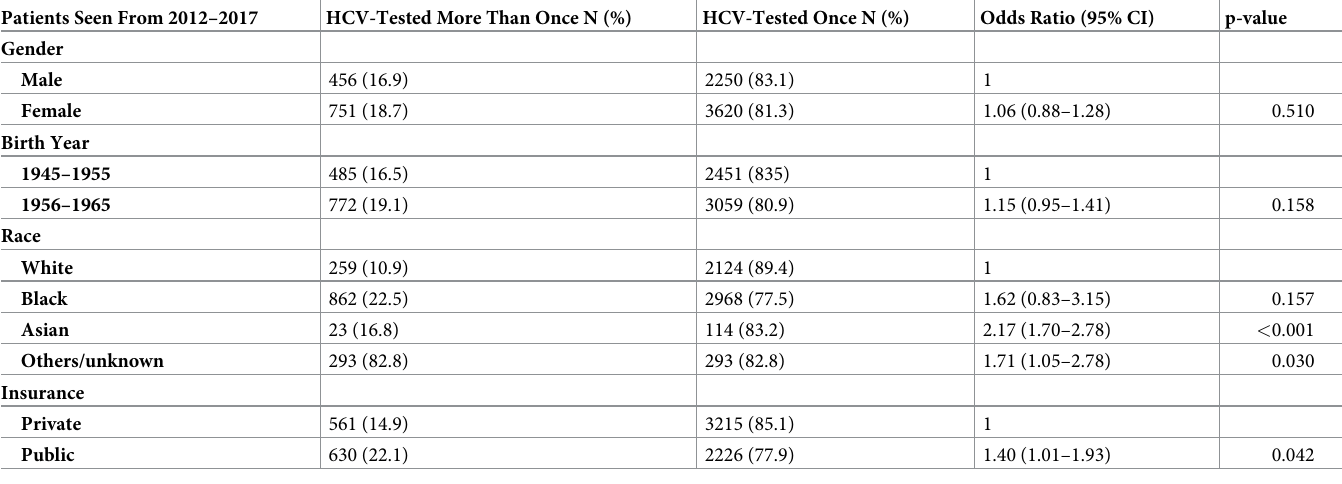
Table 3. Multivariate logistic regression for duplicate HCV screening, clustered by clinic. Patients Seen From